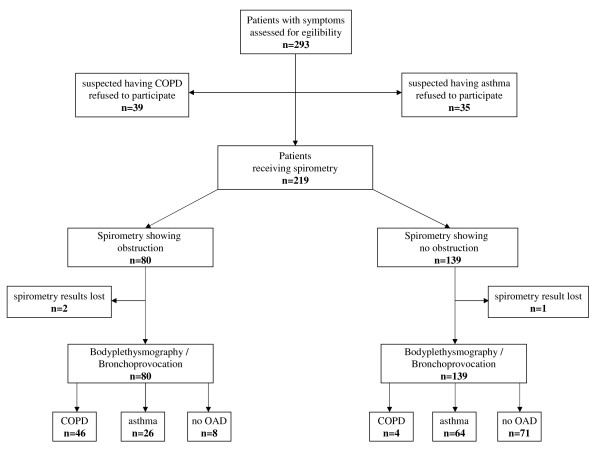
Flow chart of inclusion and diagnostic work up (COPD = Chronic obstructive pulmonary disease; OAD = obstructive airway disease; OAD = obstructive airway disease).